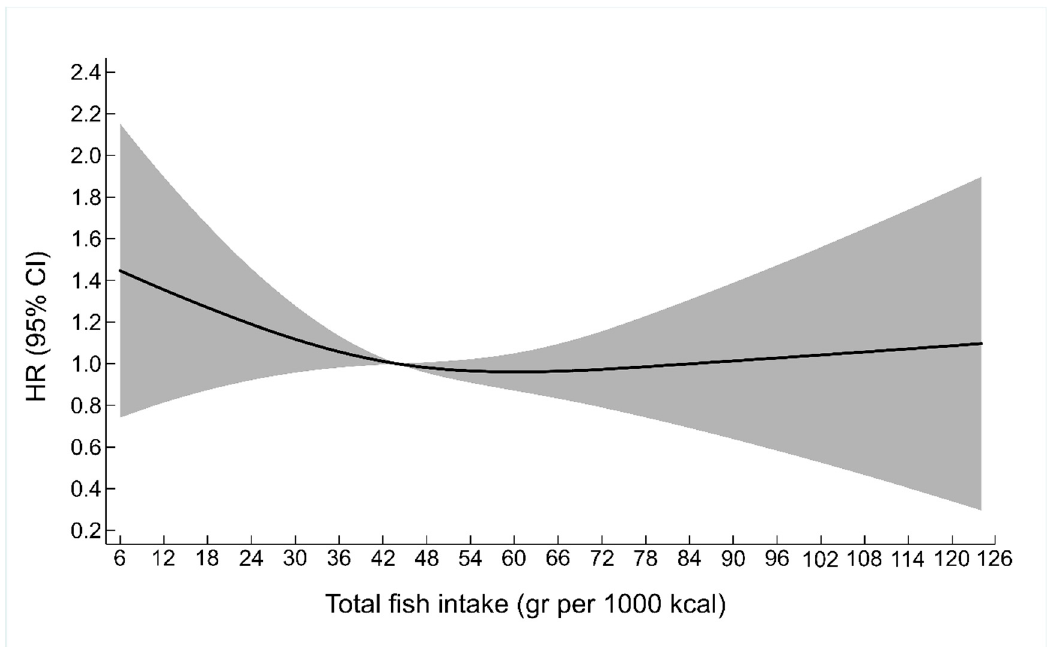
Figure 1. A restricted cubic spline exploring the non-linear association between total fish intake and the risk of hip fracture in the total cohort of men and women (70–74 years old at baseline) from the Hordaland Health Study. HR denotes Hazard Ratio, CI confidence interval.